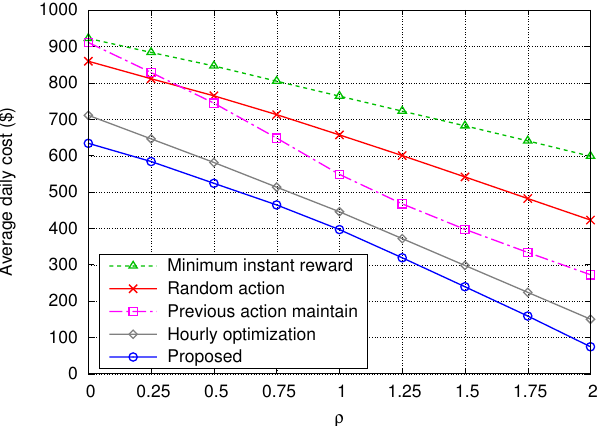
Figure 9. Average daily cost with respect to scale factor of PV system.